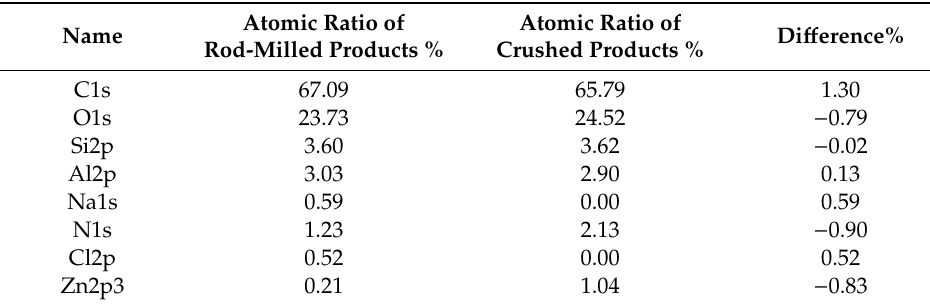
Table 1. Atomic ratios of di ff erent comminution products.